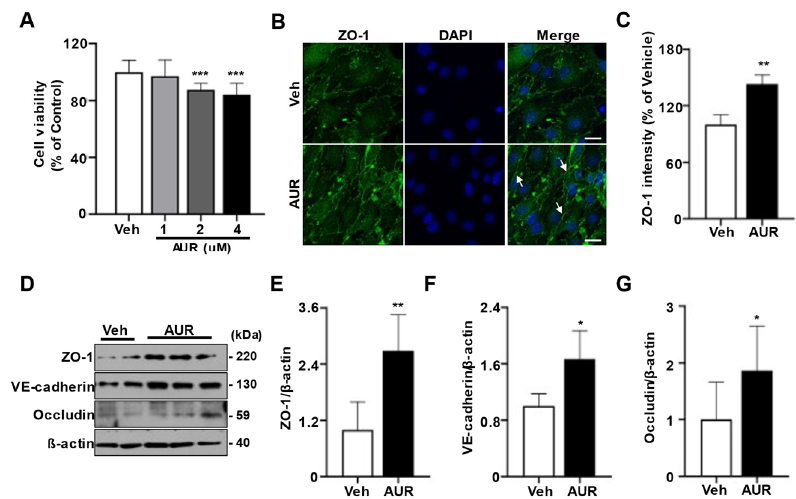
Figure 1. Effects of Auraptene (AUR) on junctional proteins expression in bEnd.3 cells. ( A ) bEnd.3 cells (5 × 10 3 cells per well) seeded in 96-well plates were incubated in media containing 0, 1, 2, 4 µM of AUR for 24 h. Cell viability was measured by SRB assay. ( B ) bEnd.3 cells with vehicle (Veh) or 1 µM AUR were stained for ZO-1 (green) and DAPI (blue); Scale bar: 20 µm. Arrows indicate an increase of ZO-1 expression. ( C ) Relative ZO-1 intensity was quantified using ImageJ. ( D ) ZO-1, VE-cadherin and occludin expression were analyzed by Western blot after treatment of vehicle or 1 µM AUR for 24 h. ( E – G ) The protein levels of ZO-1, VE-cadherin and occludin were quantified using ImageJ. Data are presented as mean and ± SEM of three independent experiments (* p < 0.05, ** p < 0.01, *** p < 0.001 compared to Veh).